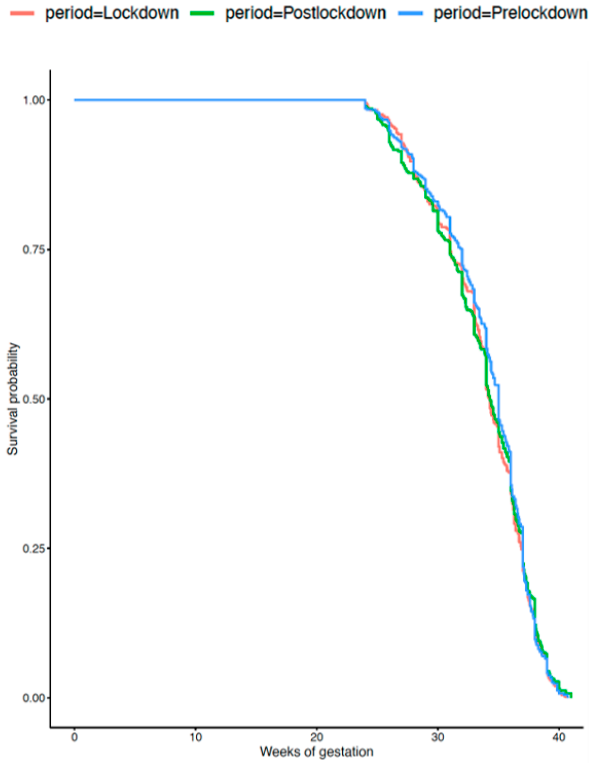
Figure 2. Gestational age at delivery for women with low birthweight (<2500 g) ( p = 0.5).